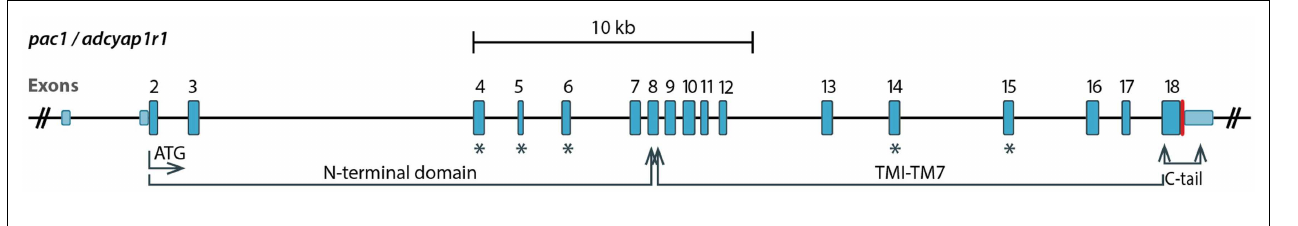
FIGURE 2 |A diagram showing genomic organization of the PAC1 ( ADCYAP1R1 ) gene . Exons 2–18 encode the open reading frame. Exons undergoing the alternative splicing discussed in this review are marked with